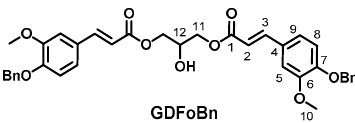
Figure 2. Glycerol dibenzyl ferulate.